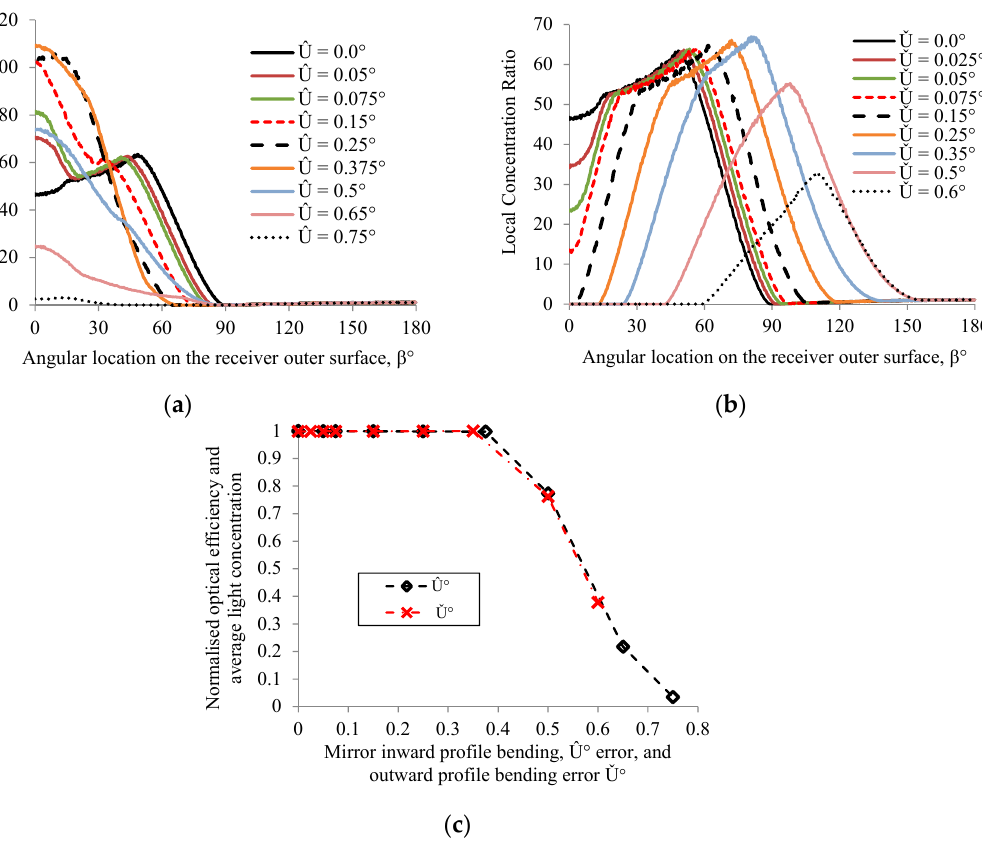
Figure 13. Effect of ( a ) inward deviation and ( b ) outward deviation of the mirror profile on the LCR profile of the receiver, and ( c ) on the η opt and C avg of the collector.